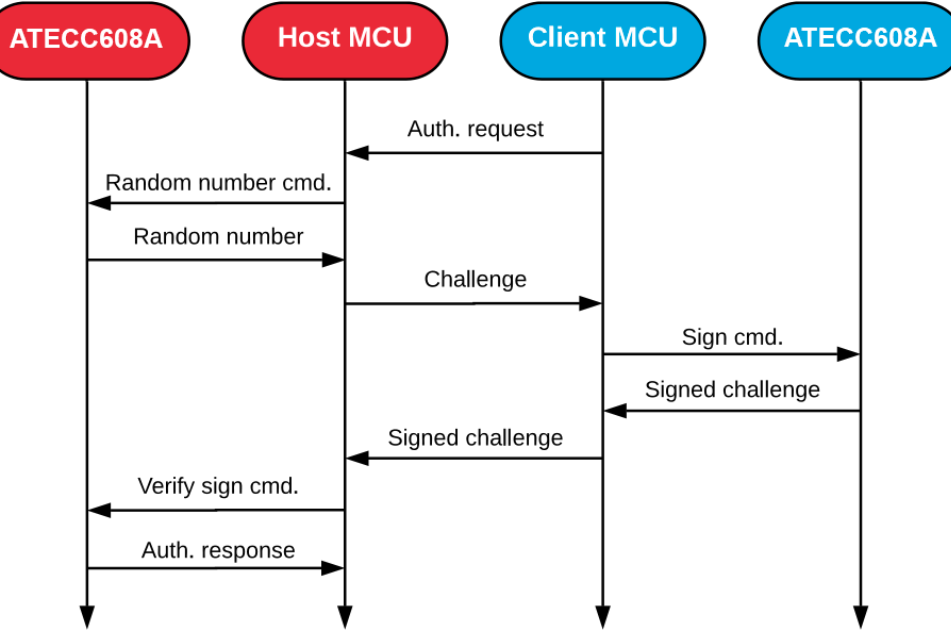
Figure 4. Time diagram of the steps followed in the authentication process between two nodes.